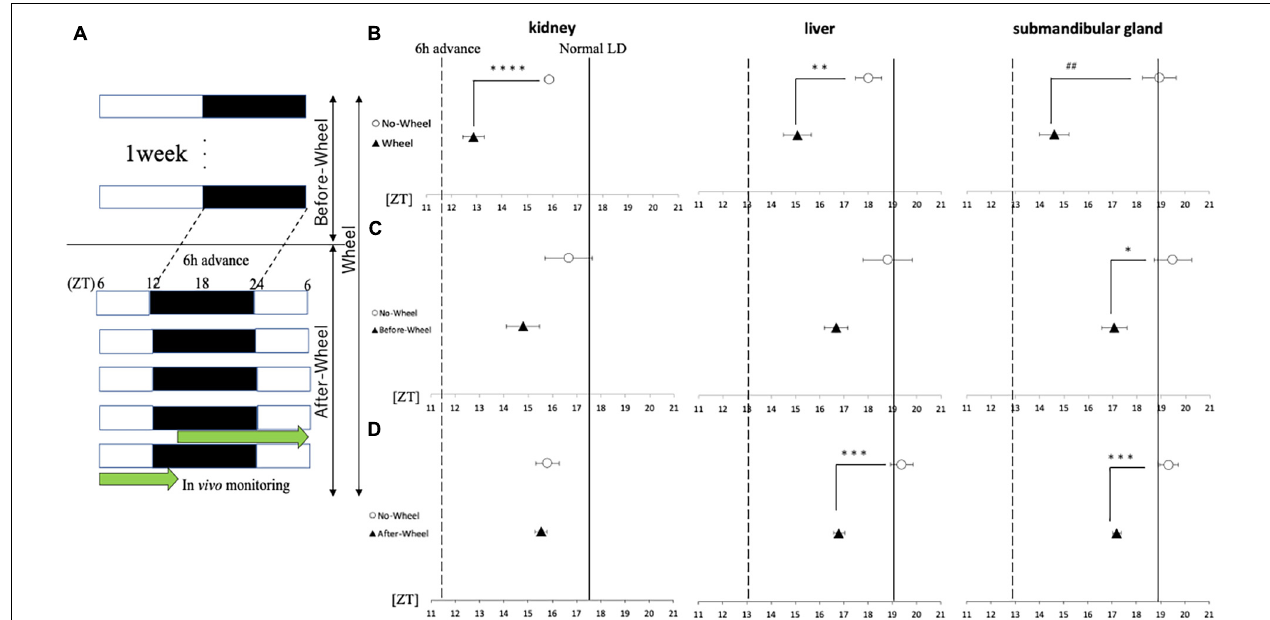
FIGURE 6 | Acrophase of PER2:LUC expression rhythm in each organ in response to 6 h of advance light conditions. (A) Protocols of three trials with different light conditions and wheel-running timings. (B–D) Comparison of the peak time of PER2:LUC expression (acrophase) in each trial. The solid line shows the acrophase under normal LD conditions with no wheel-running, and the wavy line shows the value advanced from that point by 6 h, or the acrophase that should be aimed for. Data are presented as mean ± standard error of the mean ( n = 6 for each group for all trials). * p < 0.05, ** p < 0.01, *** p < 0.001, **** p < 0.0001 (t-test); ## p < 0.01 (Mann-Whitney test).